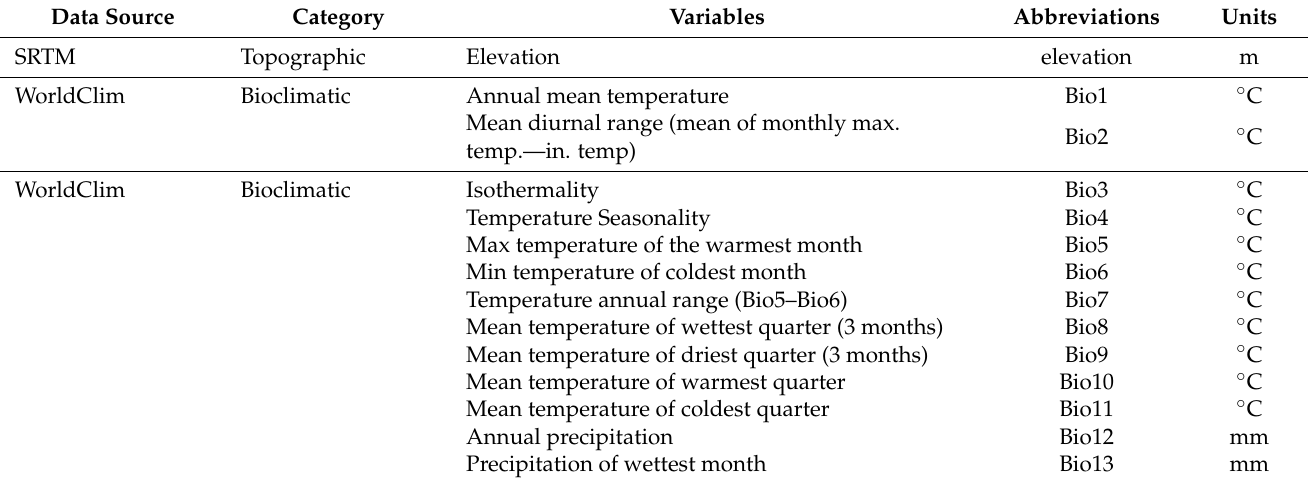
Table A1. The selected environment variables for modelling the habitat suitability distribution of M.